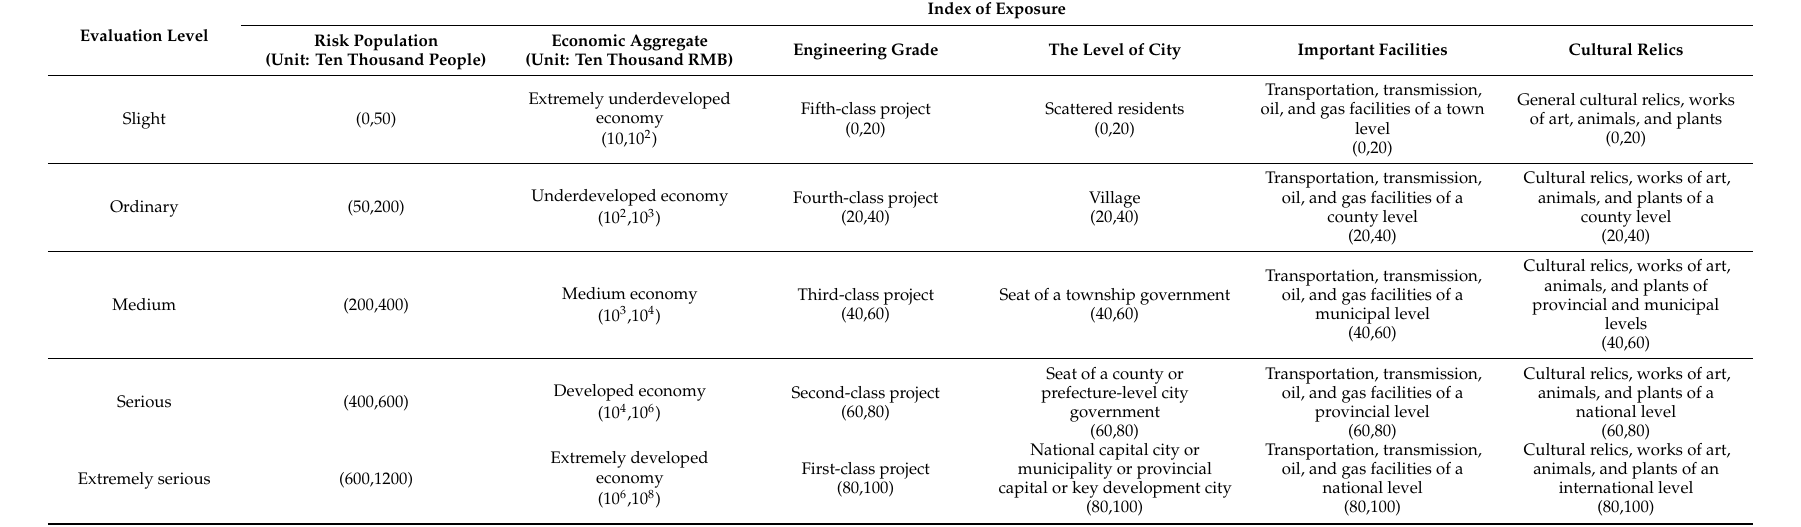
Table 3. Classification and grade suggestions for indexes of